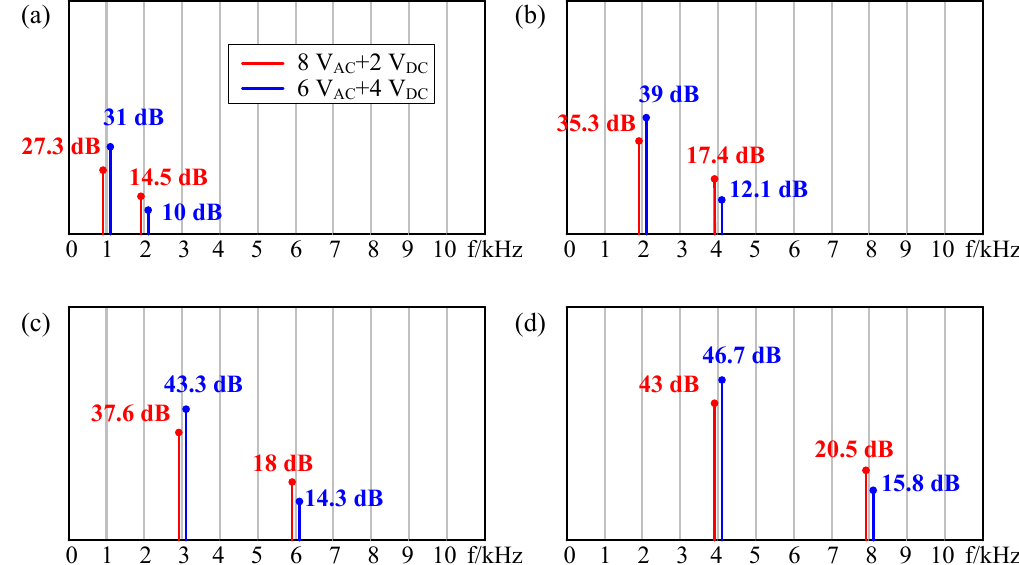
Figure 10. The results after DC excitation were smaller than those with AC excitation at frequencies of ( a ) 1 kHz, ( b ) 2 kHz, ( c ) 3 kHz, and ( d ) 4 kHz.